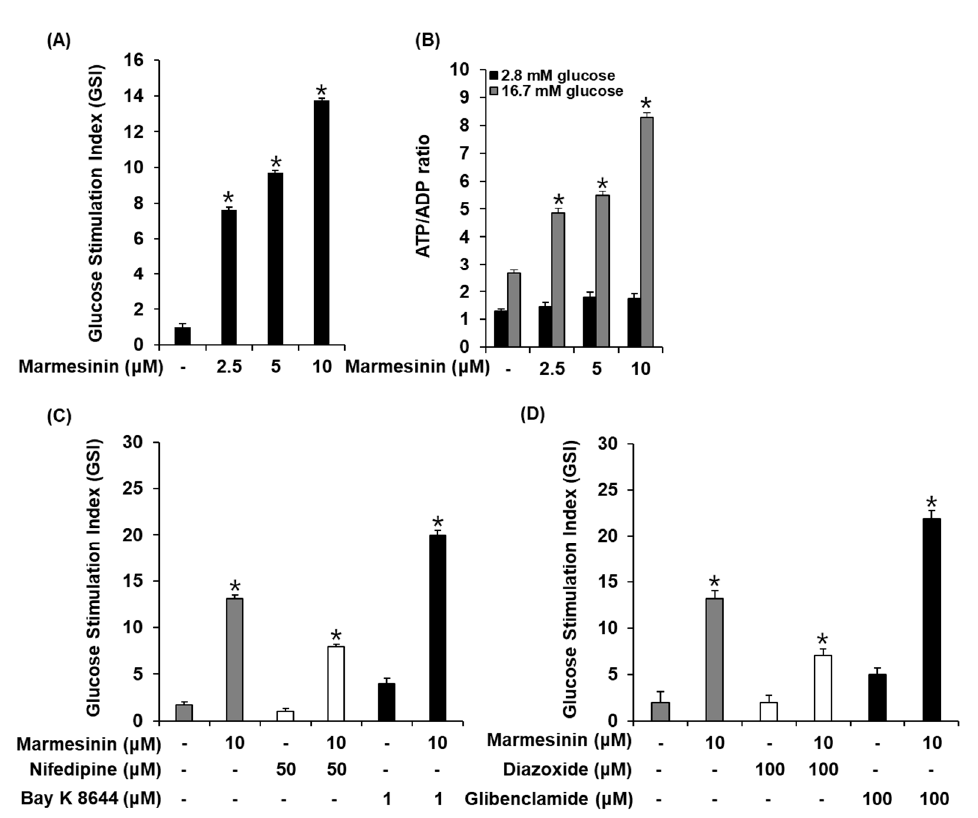
Figure 6. E ff ects of marmesinin ( 19 ) on glucose-stimulated insulin secretion in INS-1 cells. ( A ) Insu- lin secretion in INS-1 cells after 1 h incubation with basal (2.8 mM) and stimulant (16.7 mM) glucose concentrations in the presence or absence of marmesinin ( 19 ) by insulin secretion assay. ( B ) ATP/ADP ratio in INS-1 cells after 1 h incubation with basal (2.8 mM) and stimulant (16.7 mM) glucose concentrations in the presence or absence of marmesinin ( 19 ) by ADP/ATP ratio assay. ( C ) Insulin secretion in INS-1 cells after 1 h incubation with basal (2.8 mM) and stimulant (16.7 mM) glucose concentrations in the presence or absence of marmesinin ( 19 ), nifedipine (L-type Ca 2+ chan- nel blocker), and Bay K 8644 (L-type Ca 2+ channel activator) by insulin secretion assay. ( D ) Insulin secretion in INS-1 cells after 1 h incubation with basal (2.8 mM) and stimulant (16.7 mM) concentra- tions of glucose in the presence or absence of marmesinin ( 19 ), diazoxide (K + channel activator), and glibenclamide (K + channel blocker) by the insulin secretion assay. Data represent the mean ± S.E.M., n = 3, * p < 0.05 compared with control.